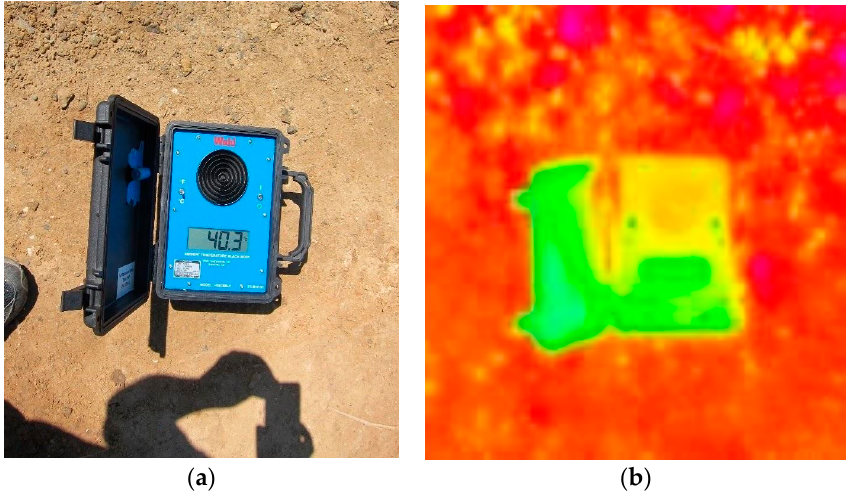
Figure 4 . Visual ( a ) and temperature ( b ) images of the NIST traceable ambient temperature blackbody used in this study. Black disk ( a ) is the blackbody temperature sensor. used in this study. Black disk ( a ) is the blackbody temperature